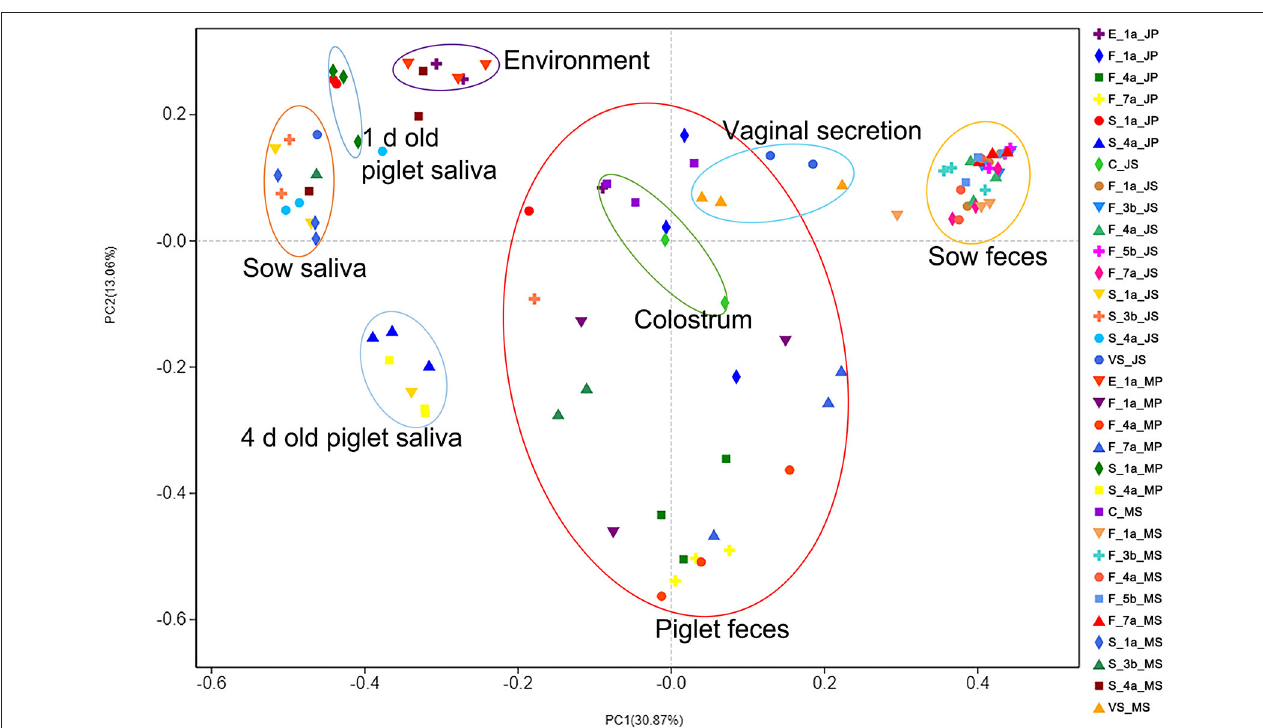
FIGURE 2 | PCoA analysis results of microbial diversity of samples from Jinfen White pig and Mashen pig. Principal coordinate analysis (PCoA) results of the sow and piglet saliva, farrowing bed environment, sow and piglet feces, colostrum, and sow vaginal secretion. Principal coordinate 1 (PC1) represents microbiota abundance, principal coordinate 2 (PC2) represents microbial community